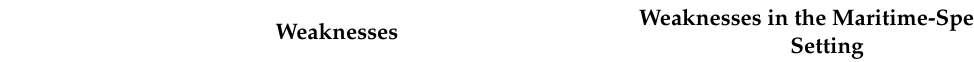
Table 3. Strengths and weaknesses of measuring methods for sleep, fatigue, and sleep behaviour in the maritime-specific study